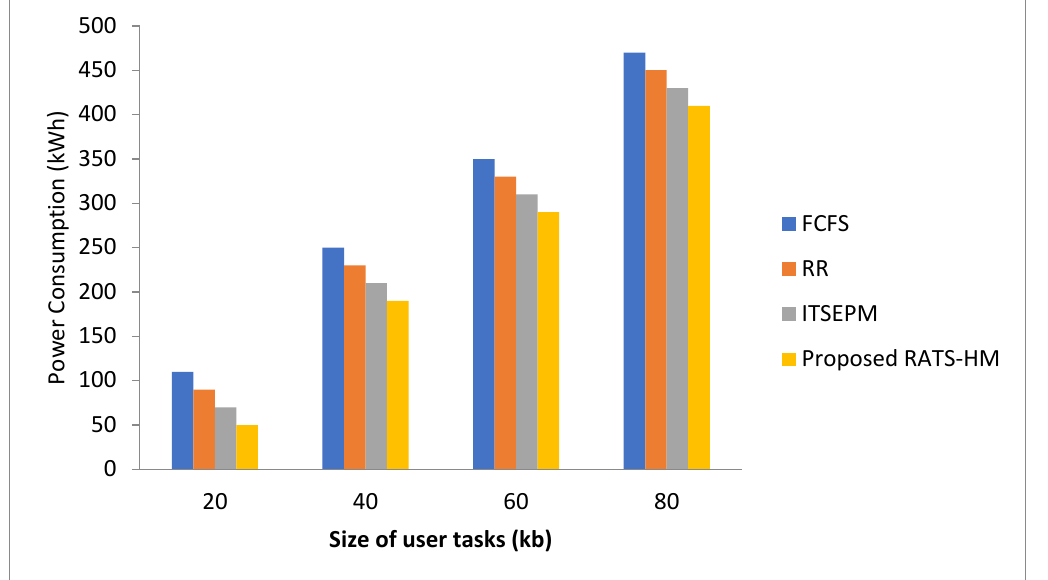
Figure 4. Existing versus proposed RATS-HM technique in terms of power consumption.